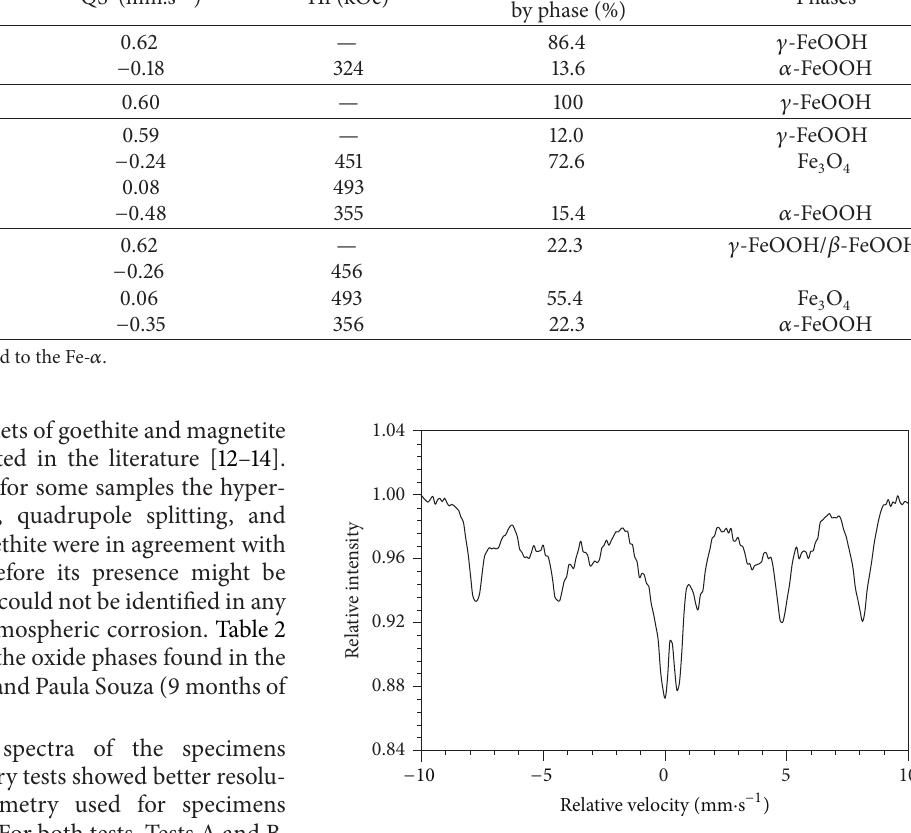
Figure 4: Representative M¨ossbauer spectrum of corrosion prod- ucts on specimen submitted to accelerated Test A.